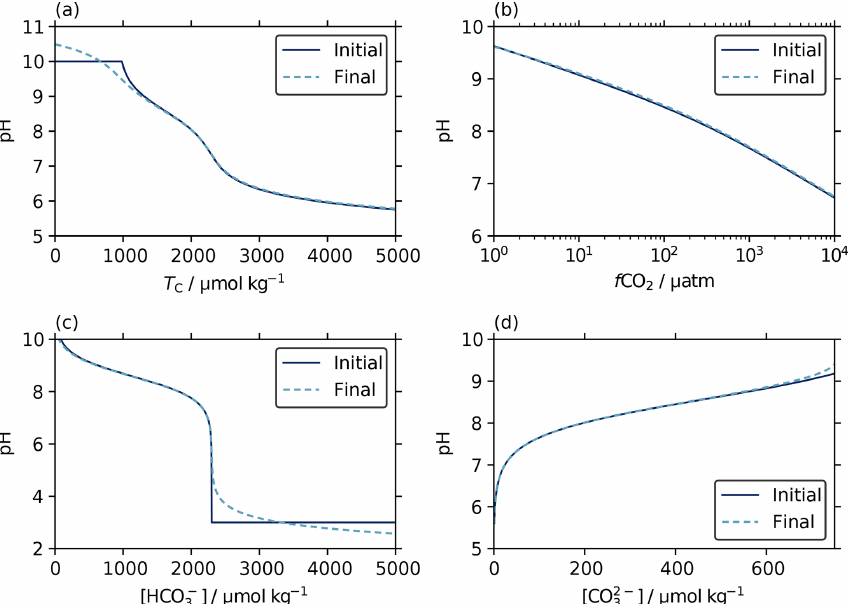
Figure 5. Initial estimates (solid lines) and final solutions (dashed lines) of pH from known parameter pairs of total alkalinity (2.3mmolkg − 1 ) with a range of values for (a) dissolved inorganic carbon ( T C ), (b) aqueous CO 2 fugacity, (c) bicarbonate ion content, and (d) carbonate ion content. The initial estimates track the final solution very closely across the range of typical seawater conditions. This is expected because these estimates were derived under the assumption that the carbonate and borate contributions are dominant in total alkalinity (Sect. 3.2), as is true for typical seawater. The default high and low pH values of 10 and 3 used where the initial estimate equations are not valid for the argument values (Eqs. 16 and F6) appear as flat sections in (a) and (c) ,